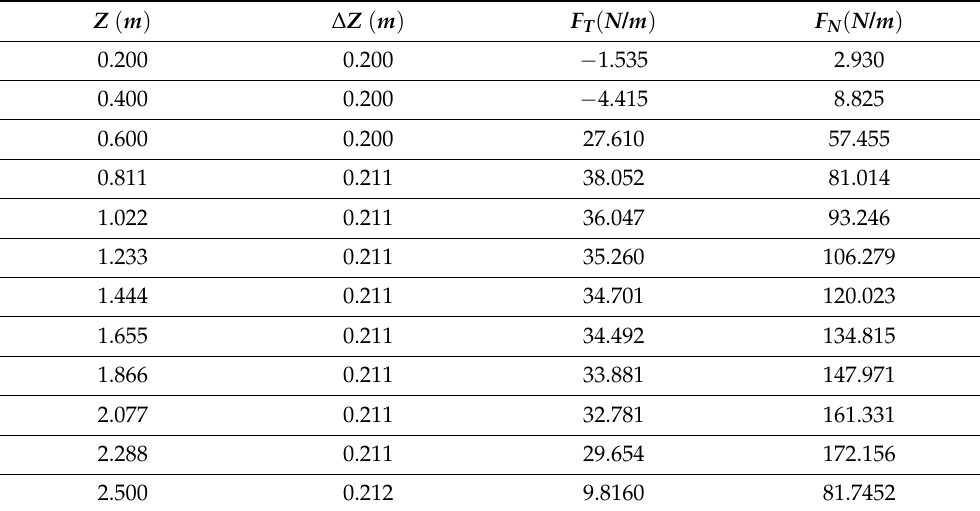
Table 4. The normal and tangential loads applied in the FE model.